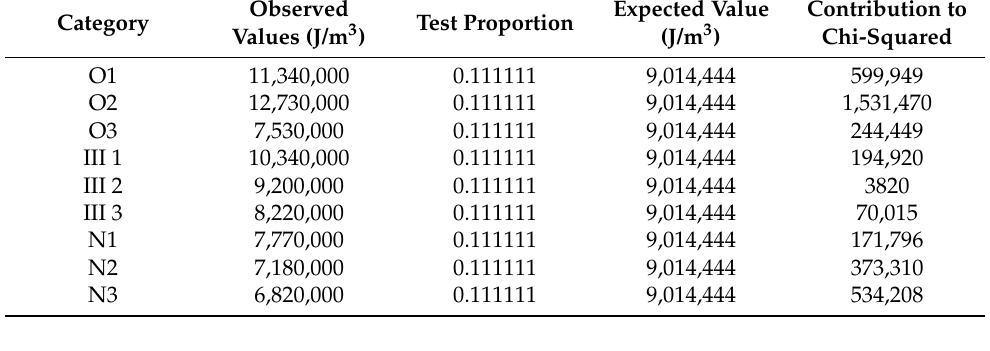
Table 4. The results of the chi-squared test for samples.